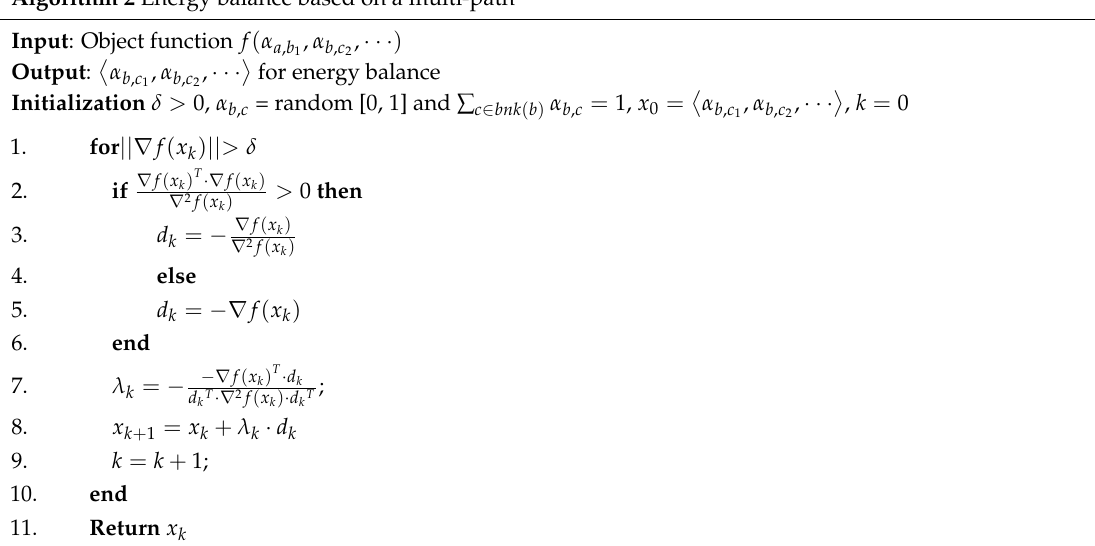
Algorithm 2 Energy balance based on a